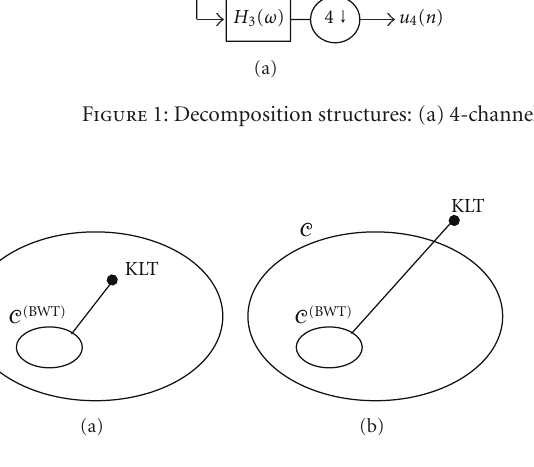
Figure 2: A sketch of M -channel filter bank class, C and its dyadic BWT subset, C (BWT) . (a) KLT in C . (b) KLT not in C .